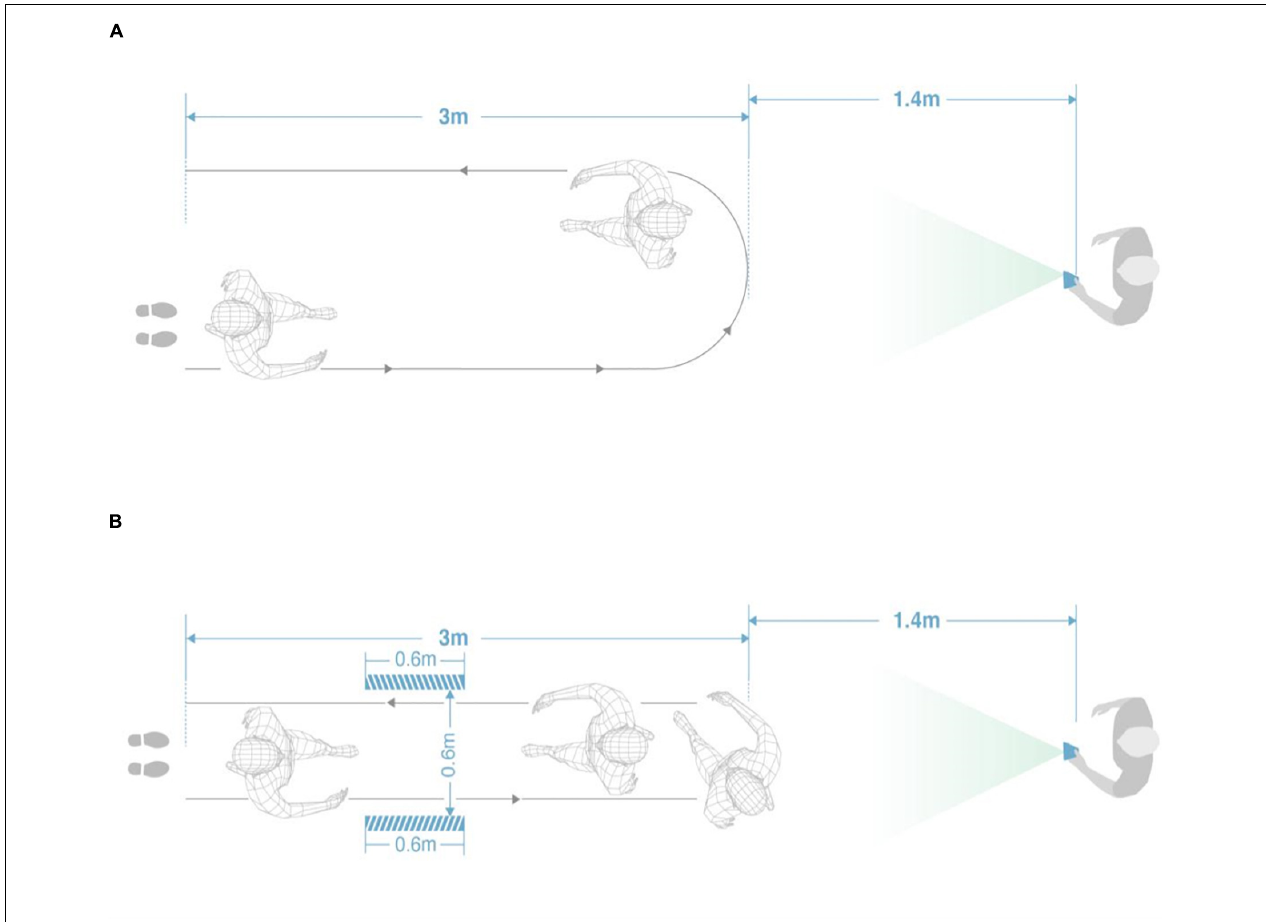
FIGURE 1 | Test diagram: (A) TUG diagram; (B) narrow TUG